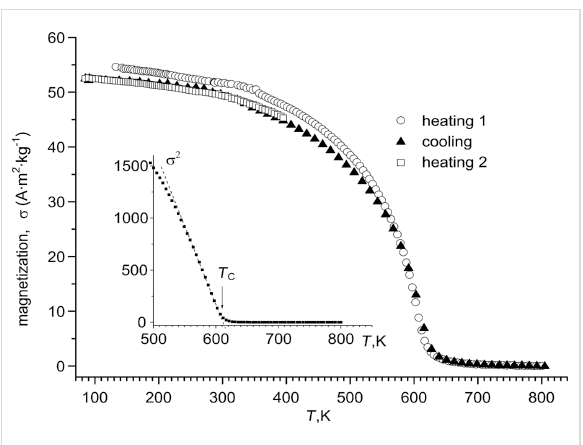
Figure 6: Magnetization as a function of the temperature for Ni NWs fabricated in the alumina template ( H PA = 65 μ m) at a current density of 3 mA·cm − 2 , the deposition duration was 90 min. The inset is the σ 2 ( T ) dependence. The dashed line represents a linear fit to the exper- imental data. The arrow indicates the evaluated T C .